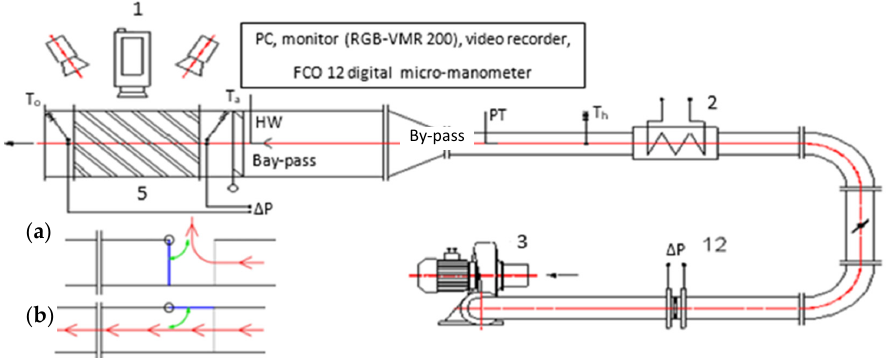
Figure 2. Open low-speed wind tunnel: 1—RGB camera (TK-1070), 2—heater, 3—fan, 4—orifice, 5—TLC test section (channel), HW—hot wire, PT—Pitot tube, T a —air inlet temperature to measurement section, T o —air outlet temperature, T h —air temperature behind heater. By-pass ( a ) valve closed: warm air goes to the environment, ( b ) valve open: warm air goes to the measuring section.